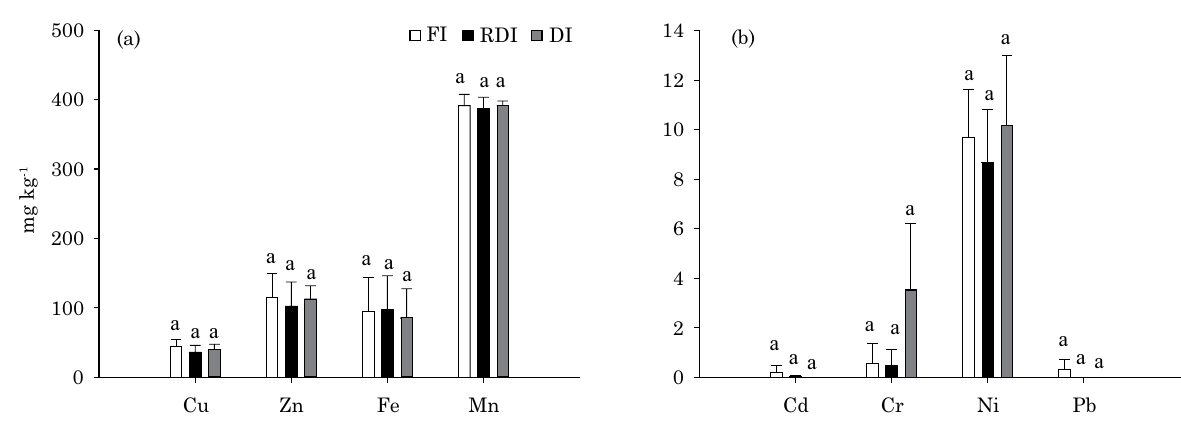
Figure 4. Micronutrient and heavy metal contents in grapevine leaves in accordance with different irrigation strategies - full irrigation (FI), regulated deficit irrigation (RDI), and deficit irrigation (DI). Columns followed by the same letter do not differ among themselves by the Tukey test at 5 % of significance. The vertical deviation bars represent the standard deviation of the mean value (n =